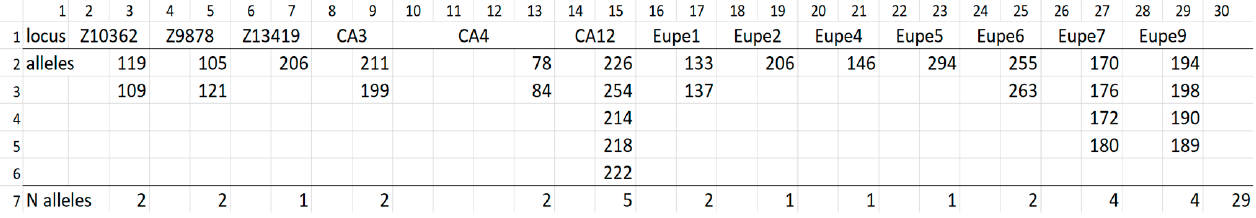
Figure 2. List of alleles detected across all profiles and loci of lake minnow individuals from Zielonka (ZI) population. Line 1, locus name; lines 2–6, alleles of loci enlisted at line 1; line 7, (columns 3–29) number of alleles detected at given locus across of samples and across all loci (column 30).